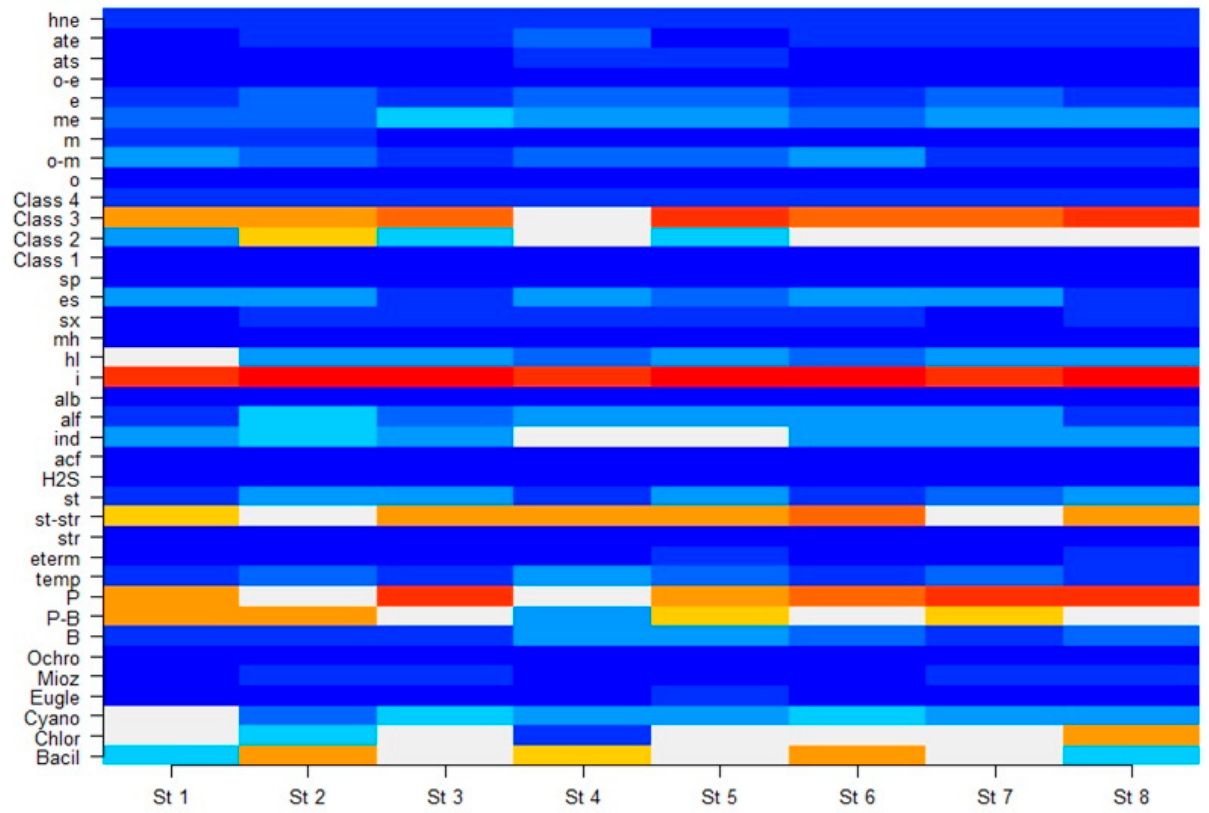
Figure 7. Heat map for distribution of indicators in phytoplankton communities over the sampling stations at Lake Borovoe, 2019. Abbreviations: Bacil, Bacillariophyta; Chlor, Chlorophyta; Cyano, Cyanobacteria; Eugle, Euglenozoa; Mioz, Miozoa; Ochro, Ochrophyta; B, benthic; P-B, plankto- benthic; P, planktonic; temp, inhabitants of temperate-temperature waters; eterm, eurythermic; str, streaming well-oxygenated waters inhabitants; st-str, inhabitants of standing to streaming middle- oxygenated waters; st, inhabitants of standing low-oxygenated waters; H 2 S, sulfides anoxia indicators; acf, acidophilic; ind, pH indifferent; alf, alkaliphilic; alb, alkalibiontes; i, chlorides indifferent; hl, halophiles; mh, mesohalobes; sx, saproxenes; es, eurysaprobes; sp, saprophiles; Classes 1–4 of water-quality indicators according to Index S; o, oligotraphentes; o-m, oligo-mesotraphentes; m, mesotraphentes; me, meso-eutraphentes; e, eutraphentes; o-e, oligotraphentes to eutraphentes; ats, autotrophes-inhabited low-nitric-nitrogen waters; ate, autotrophes-inhabited high-nitric-nitrogen waters; hne, facultative-heterotrophes-inhabited low organically enriched waters. In the x -axis are station numbers, and in the y -axis are the same abbreviations as in Appendix Table A3. The color of the cells varies from white to blue and then to red, according to the proportion of the number in the entire distribution.